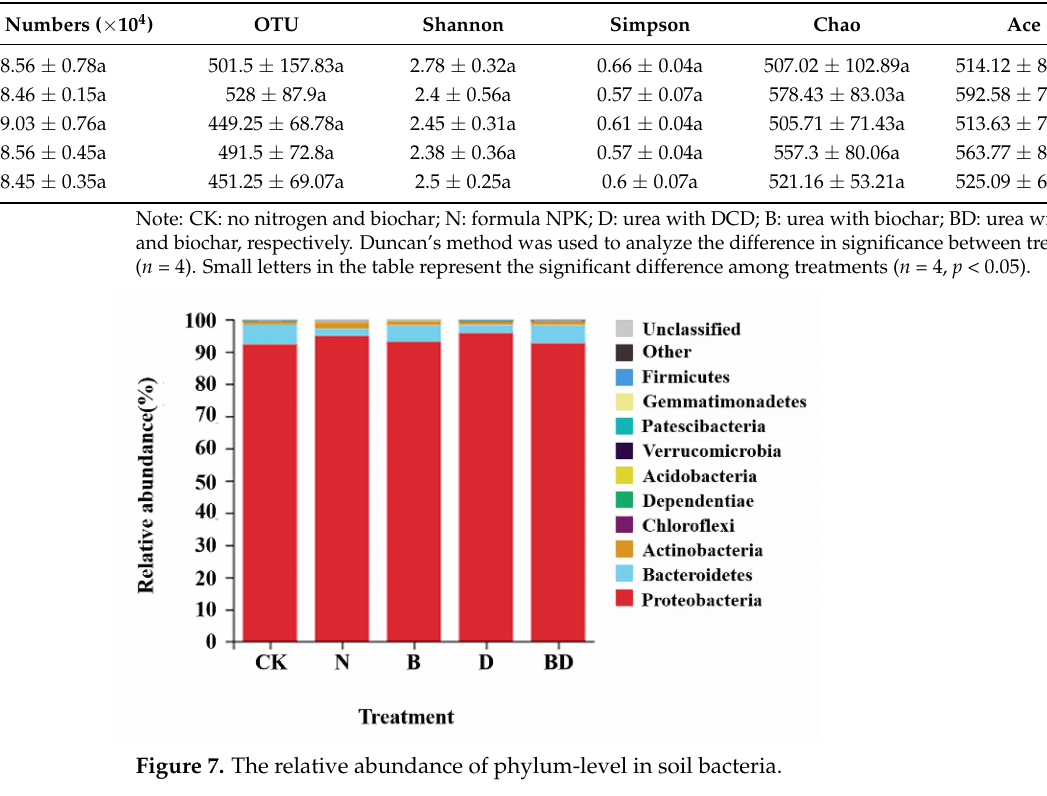
Table 1. Comparison of α -diversity indices and read numbers under different treatments at a genetic distance of 3%.